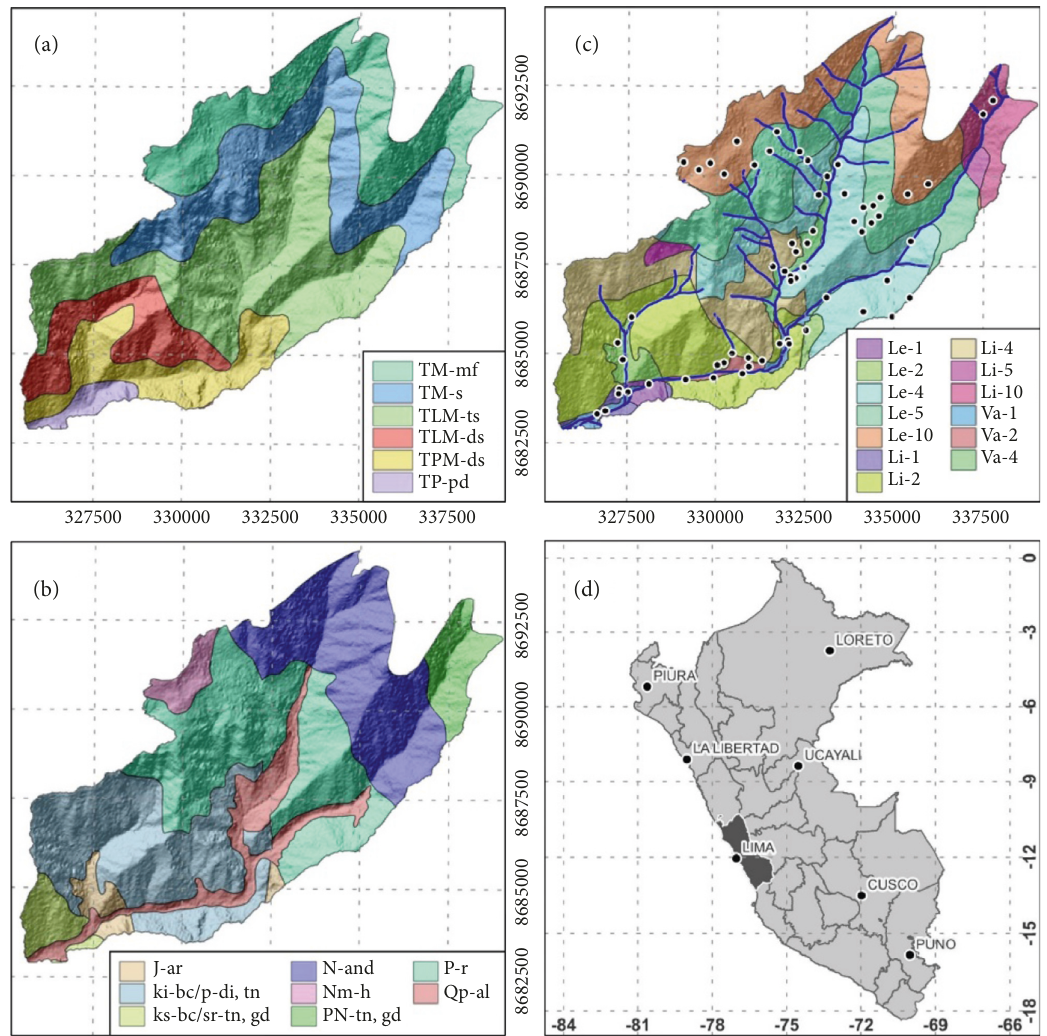
Figure 1: Holdridge life zones (a), geological map units (b), homogeneous land units, channel network and sample locations (c), and the location of the study area